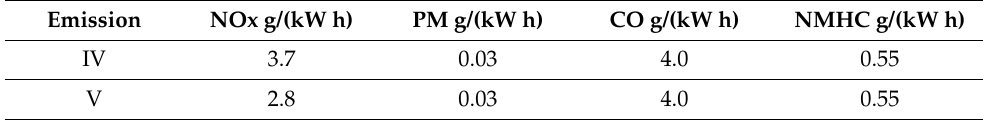
Table 11. WHTC value, adapted from Bai et al.